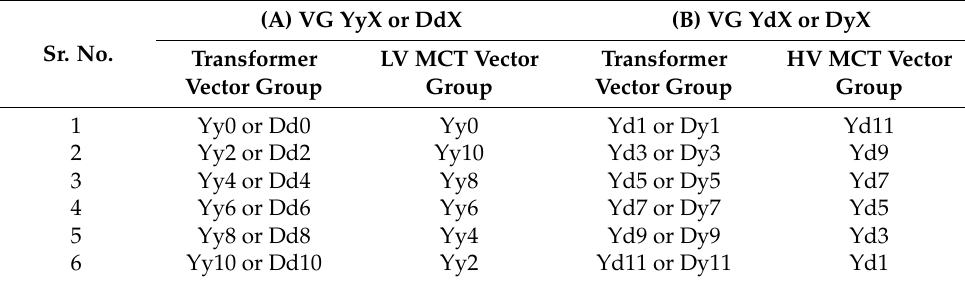
Table 1. LV MCT vector group configuration for transformers: ( A ) with vector group YyX or DdX, ( B ) transformers with vector group YdX or DyX.